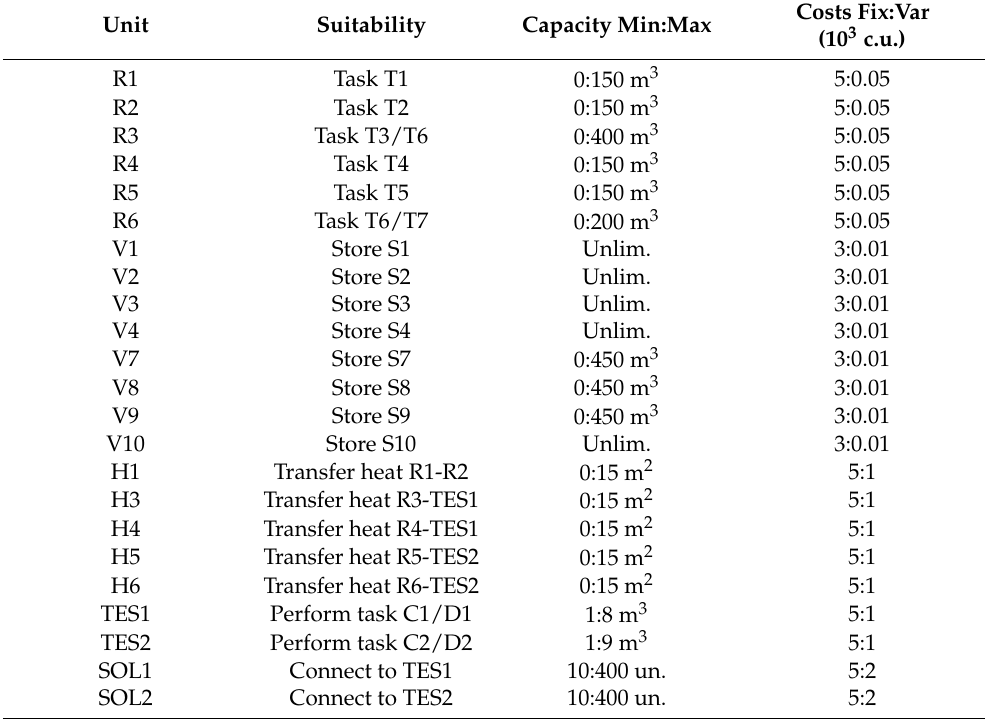
Table 6. Unit characteristics of Example II.